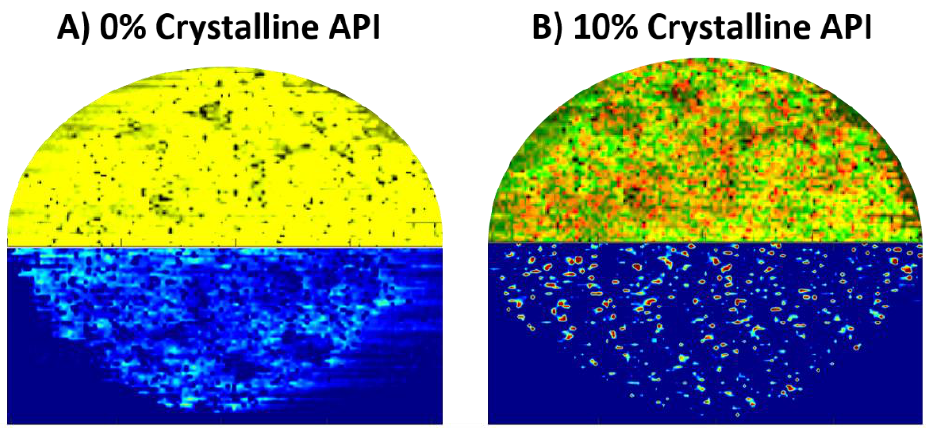
Figure 2. Co-localization plots of acetaminophen and the L90 surfactant (top half) with ELDI-MSI (bottom half) of ( A ) 0% crystalline (100% amorphous) and ( B ) 10% crystalline standard acetaminophen tablets. The co-localization plots on top compare acetaminophen at m/z 152.07 and the L90 surfactant at m/z 458.42. The MS images on bottom represent the spatial distributions of just the API.